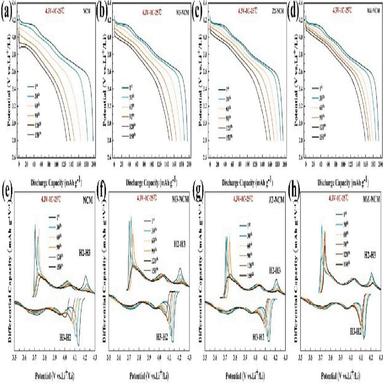
Discharge profiles of (a) NCM, (b) M3-NCM, (c) Z2-NCM and (d) MZ-NCM and dQ/dV curves of (e) NCM, (f) M3-NCM, (g) Z2-NCM and (h) MZ-NCM.